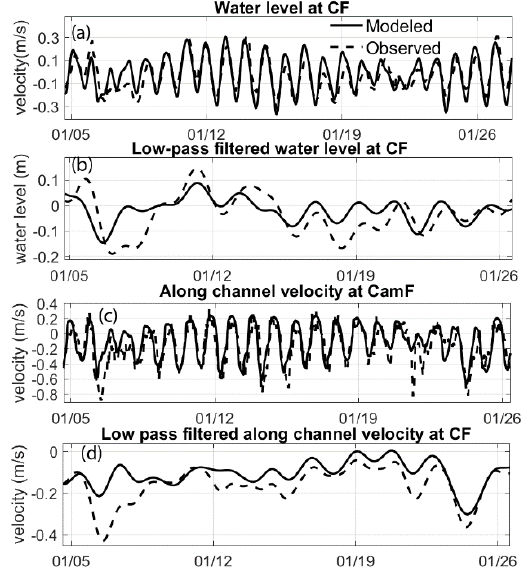
Figure 2. Validation of water level and along-channel velocity using observation in January 2014 at Caminada Pass, ( a , c ) are validations of water elevation and surface flow at Caminada Pass, ( b , d ) are validations of low-pass filtered water elevation and along channel velocity at Caminada Pass. Skill score for water level and along channel simulation are 0.7 and 0.67, which are categorized as “excellent”.